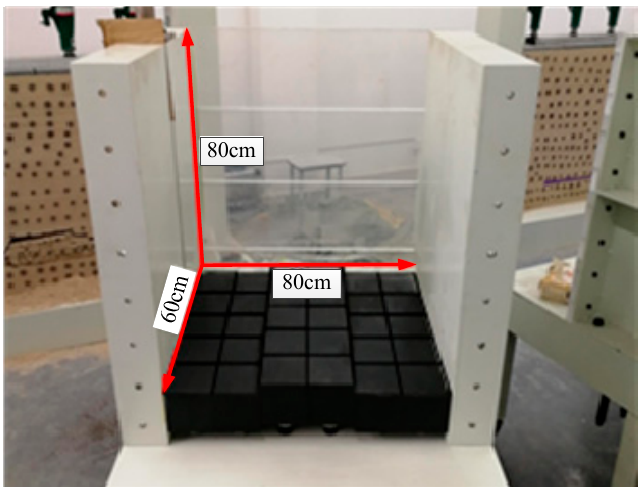
Figure 2. The three-dimensional test device for simulating surface movement in underground coal mining.